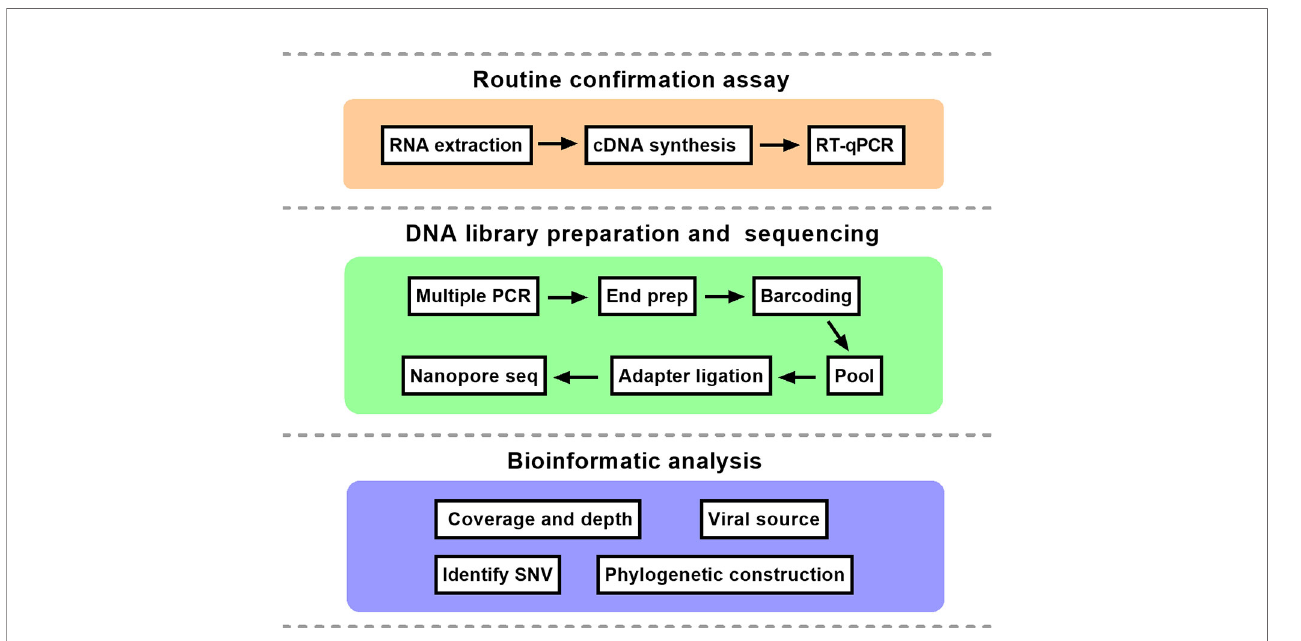
FIGURE 1 | The schematic overview of nanopore sequencing based on multiplex PCR. The protocol mainly consisted of three parts. RT-qPCR, reverse transcription quantitative polymerase chain reaction; SNV, single nucleotide